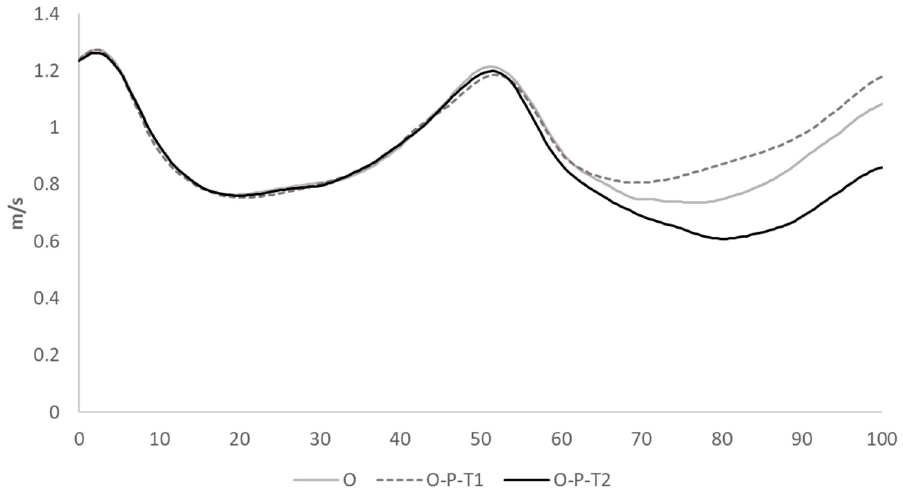
Figure 4. Average plots of pelvis COM velocity (COMv) across unperturbed (gray), early perturbation of obstacle to platform (O-P-T1, dashed line) and late perturbation (O-P-T2, black line) conditions. Gait stride was normalized to 100% with toe-off fixed at 60%.